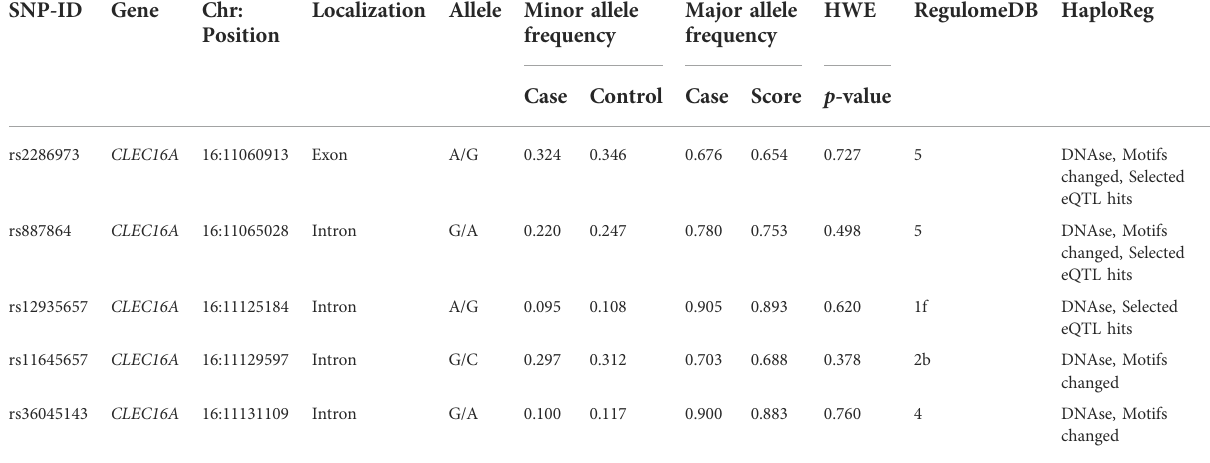
TABLE 2 Basic information of CLEC16A